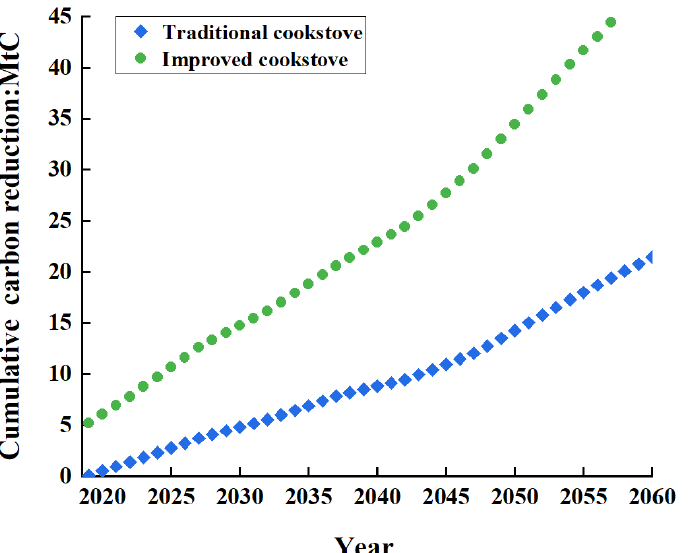
Figure 9. Cumulative bioenergy reduction from traditional and modified cookstoves in arboreal forests in Henan Province, 2019–2060.